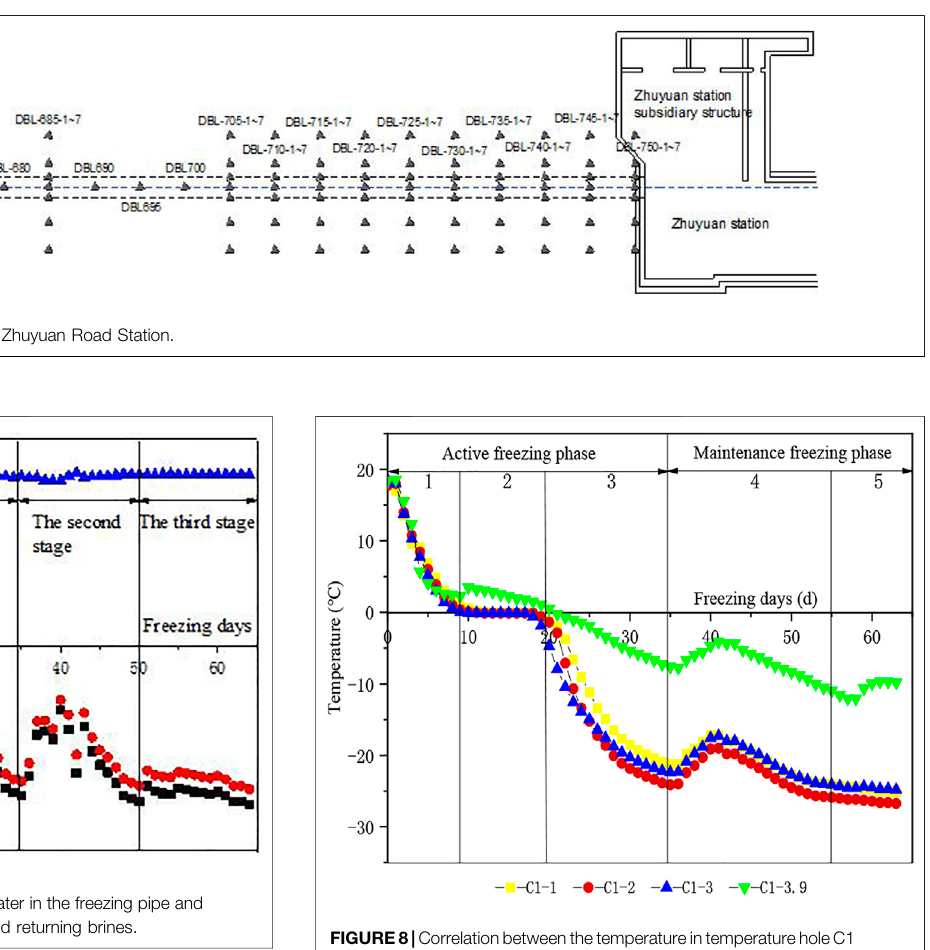
Frontiers in Earth Science |